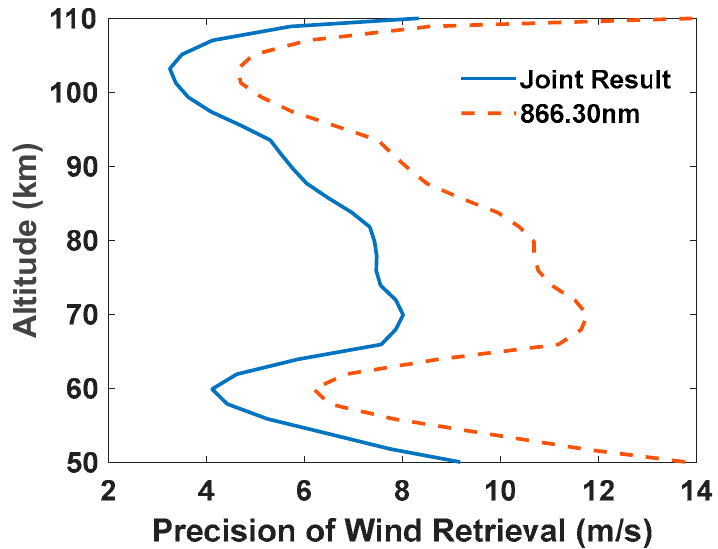
Figure 15. Comparison of the wind retrieval precision of the joint method and the best single line (866.30 nm).